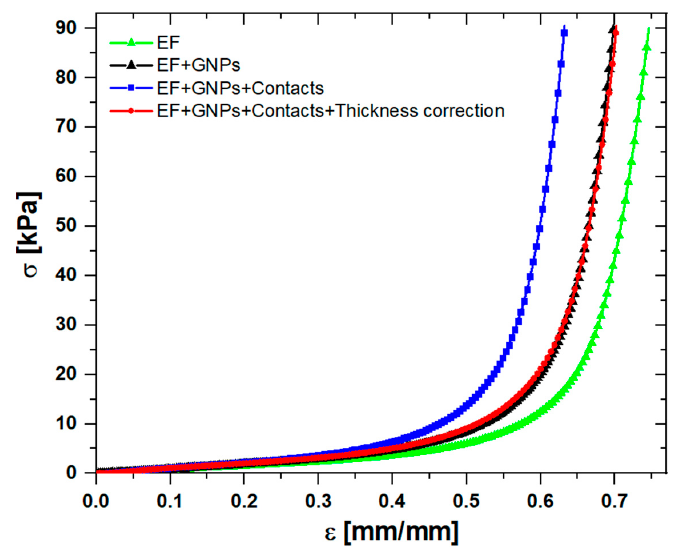
Figure 7. Differences in the mechanical behavior of the foam with and without the electrical contacts.